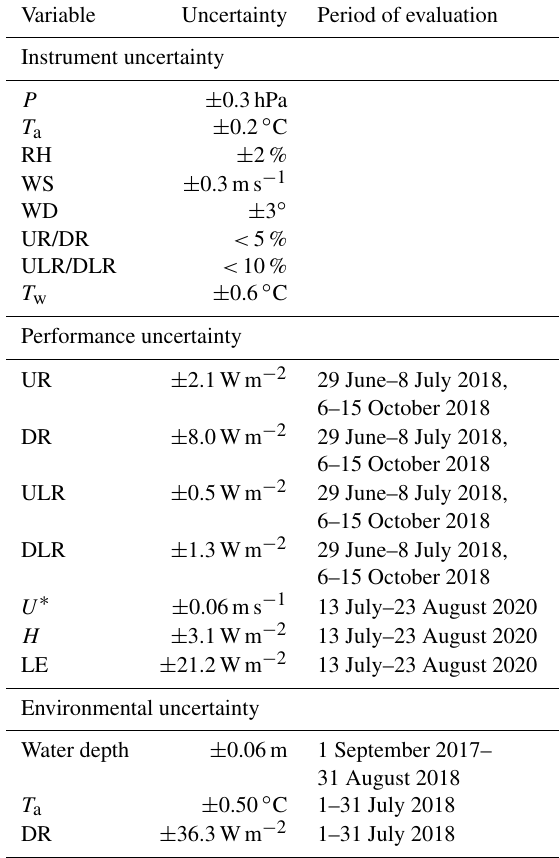
Table 5. Uncertainty of key measurement variables at half-hourly intervals. Instrument uncertainty is provided by the manufacturers. Performance uncertainty is 1 standard deviation of the difference between measurements made by the field instrument and the vali- dation instrument. Environmental uncertainty is the spatial standard deviation of the variable measured at the lake